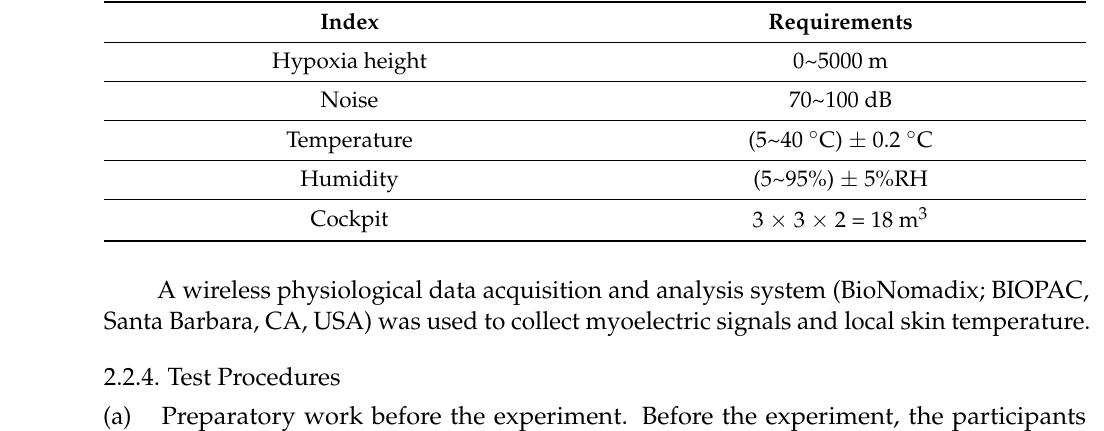
Table 2. Design indexes of the environmental simulation cockpit.